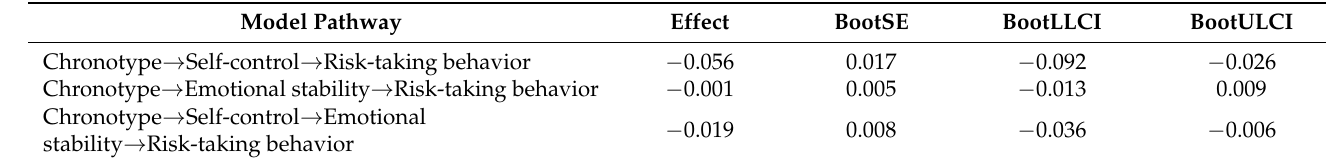
Table 3. Standardized indirect effects and 95% CIs for the mediational model ( n =